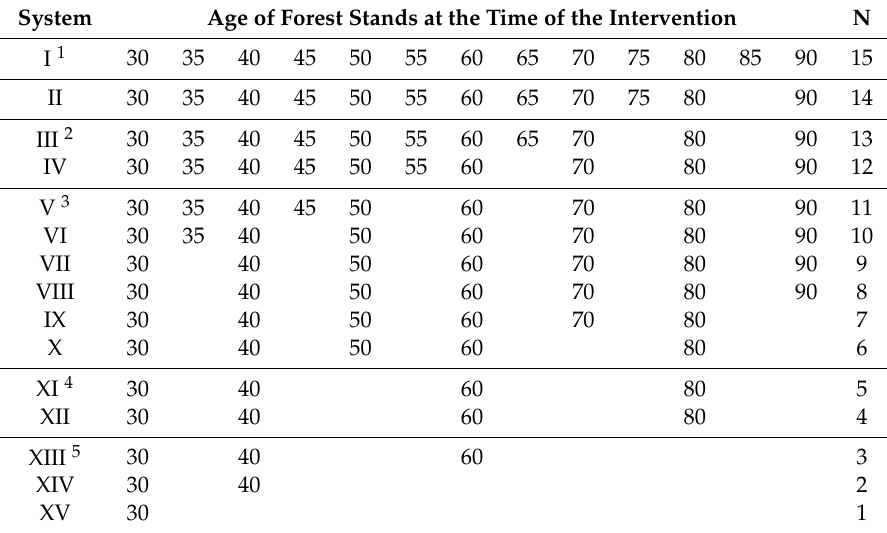
Table 2. Tending systems—timing and number of interventions.